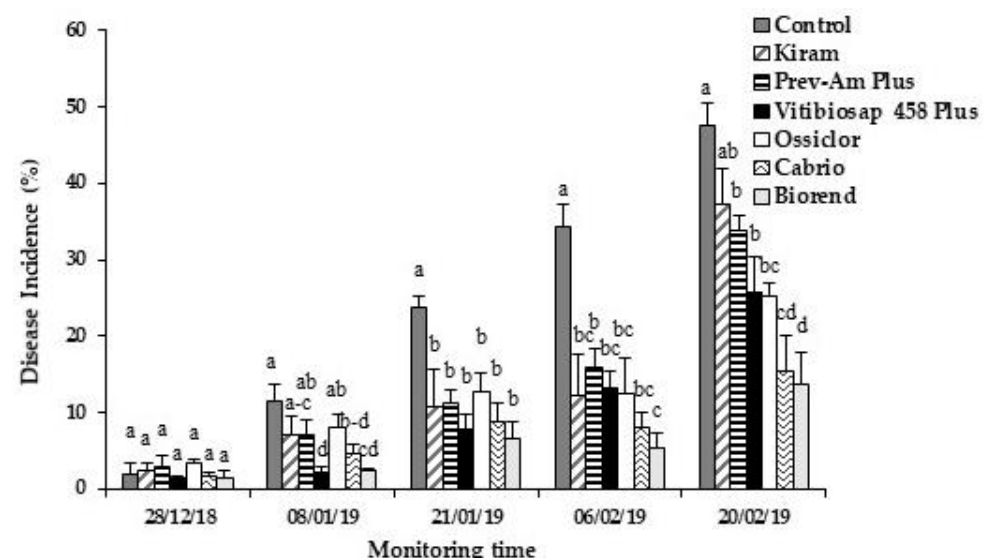
Figure 2. Time progression of natural anthracnose symptoms on citrus fruits cv. “Tarocco Scir é ” treated in the field with alternative products, Ossiclor or Cabrio. Field treatments were carried out three times (28 December 2018; 15 January 2019; 6 February 2019). Disease incidence was expressed as percentage of symptomatic fruits/treatment. Bars represent the standard error of the mean (SEM). Columns with different letters are statistically different according to Fisher’s least significance difference test (LSD) at p -value < 0.05.